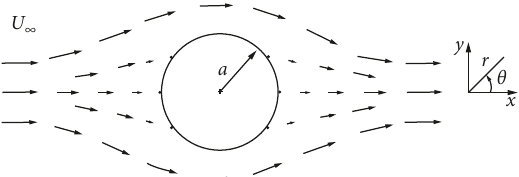
Figure 7: Normal stress of phason field versus time (a) at the point A A ) towards the right in the horizontal direction; (c) at the point A 2 reprinted from [11], copyright 2017 with permission from Springer Nature.